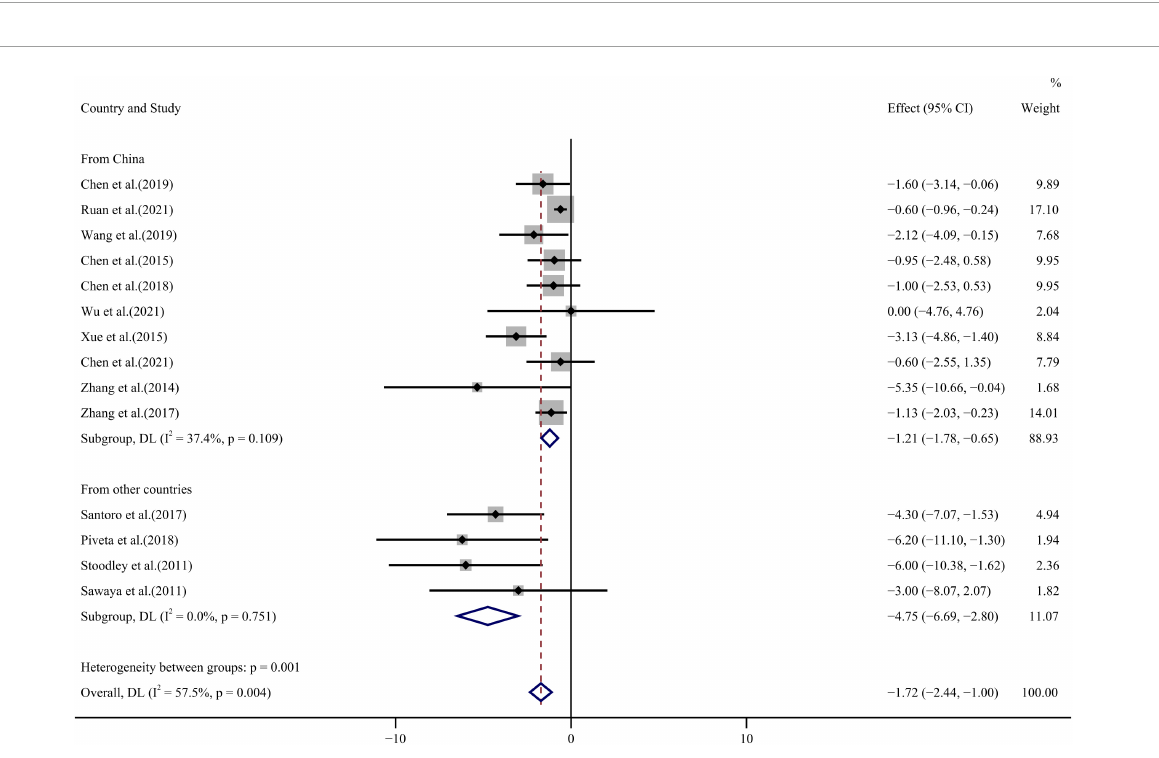
Frontiers in Cardiovascular